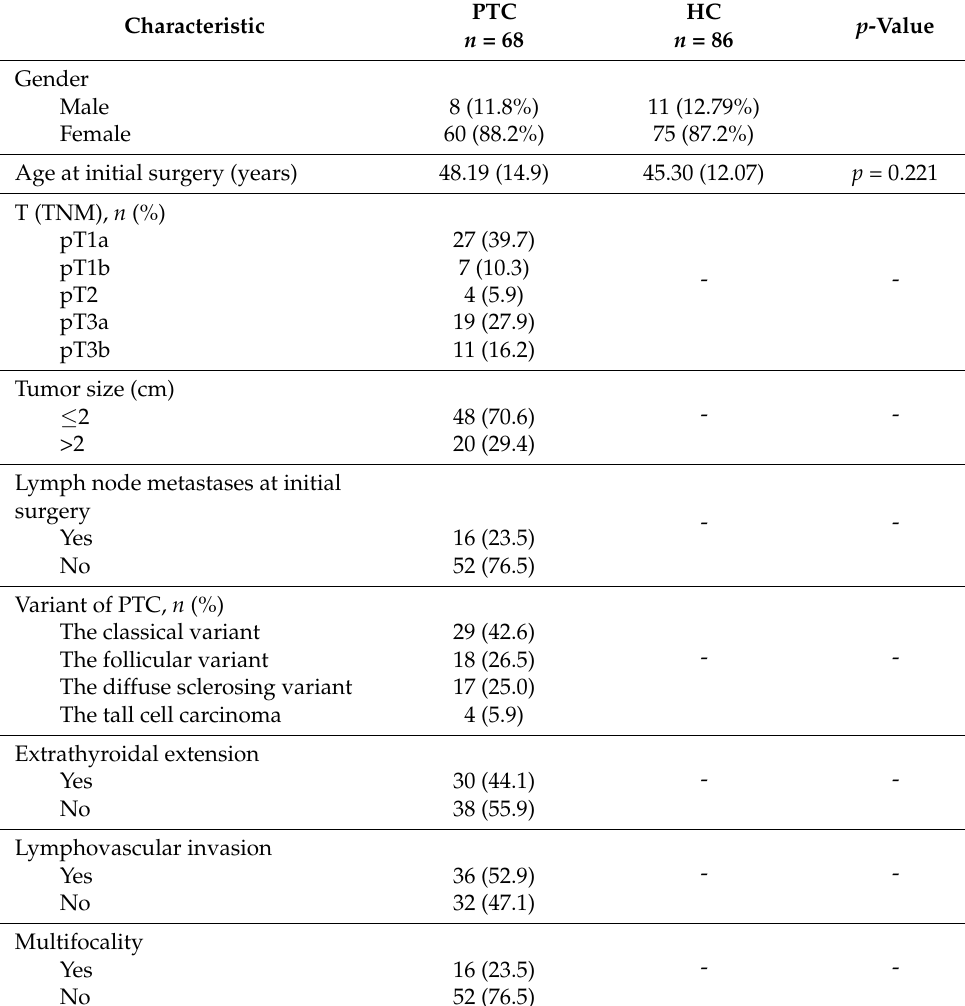
Table 1. Demographic and clinicopathological characteristics of the study population with PTC and